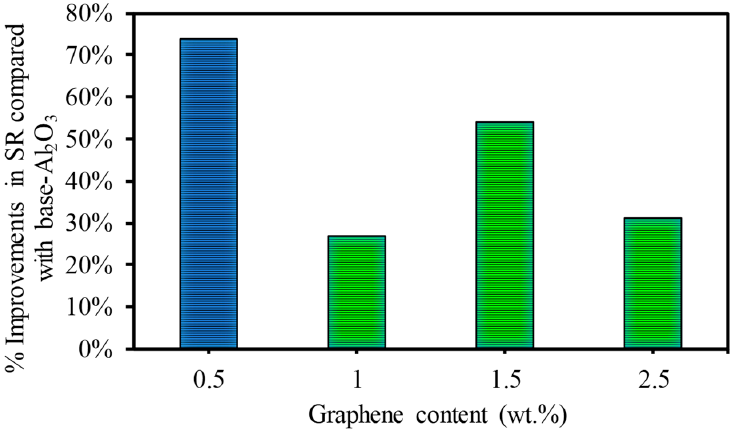
Figure 18. Percentage of improvement in surface roughness at a lower scanning speed of 200 mm/s. Regarding the effects of the frequency, Figure 19 presents the effects of the GNP contents with varying frequencies on the surface roughness of the microchannels. It can be observed in Figure 19 that the surface roughness increased with increases in the GNP contents from 0.5 wt.% to 1 wt.% and then decreased when the GNP contents increased to 1.5 wt.%. After that, the surface roughness increased with increasing GNPs to 2.5 wt.%. This trend was almost the same as in the case of the channel depth shown in Figure 13a. This is attributed to differences in the material properties of the developed nanocomposites. The nanocomposites with 0.5 wt.% GNPs had the lowest surface roughness compared to the base Al 2 O 3 and the 1 wt.%, 1.5 wt.%, and 2.5% GNP/Al 2 O 3 by approximately 287%, 132%, 28%, and 165%, respectively, at a lower frequency of 20 kHz. The 2.5 wt.% GNP nanocomposite exhibited higher surface roughness than all the other specimens. This happened because of the lower ablation threshold and optical absorption in the case of the 2.5 wt.% GNP specimens, which led to a higher ablation depth with an increase in the surface roughness due to redeposited material on the bottom surface of the channel.